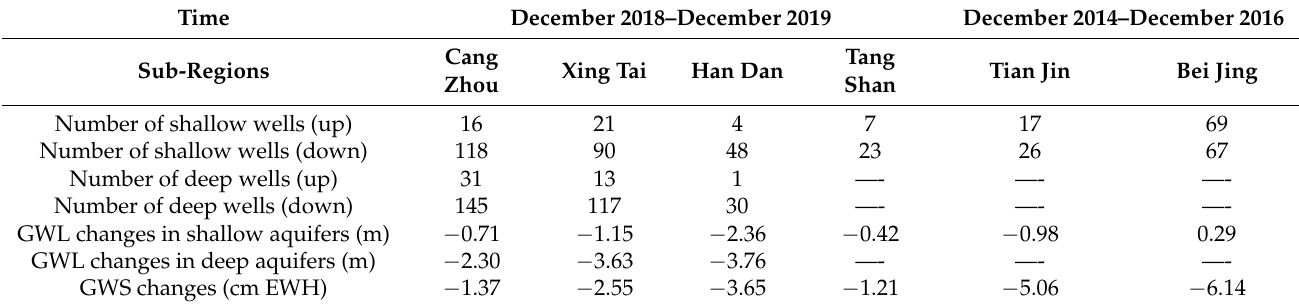
Table 2. Statistics of GWL observations and GWS changes in the